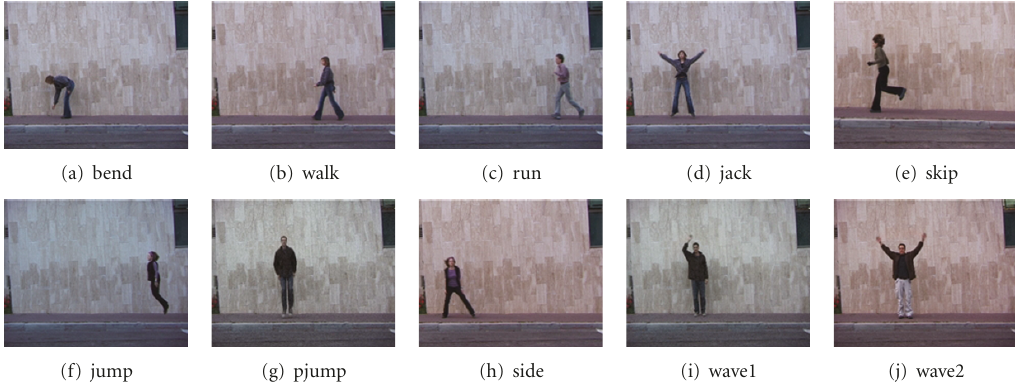
Figure 8: Selected frames from Weizmann dataset.